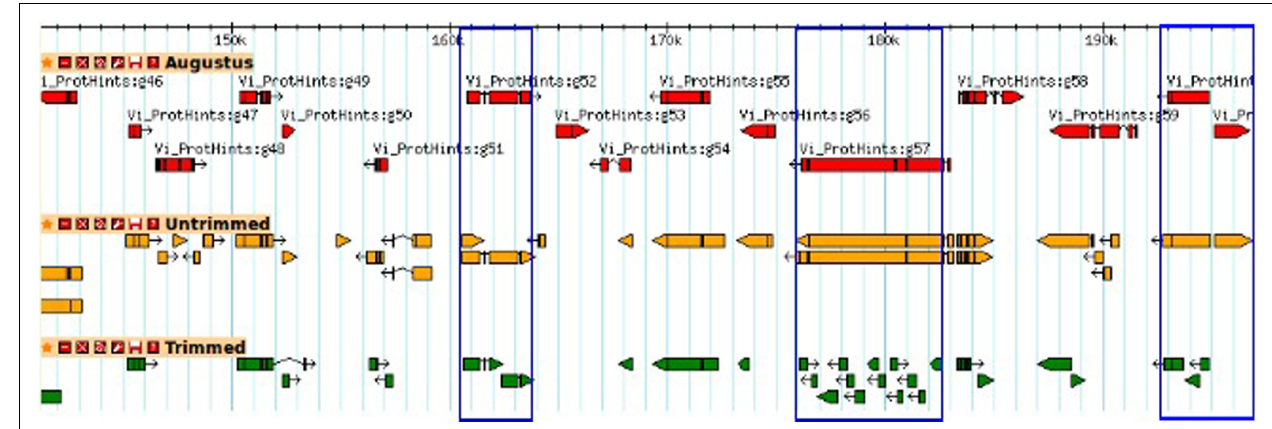
FIGURE 2 |A GBrowse snapshot of predicted genes and transfrags (TFs) for V. inaequalis . Ab initio gene predictions are shown in red.TFs produced by Trinity with untrimmed and trimmed (category one) reads are shown in orange and green,